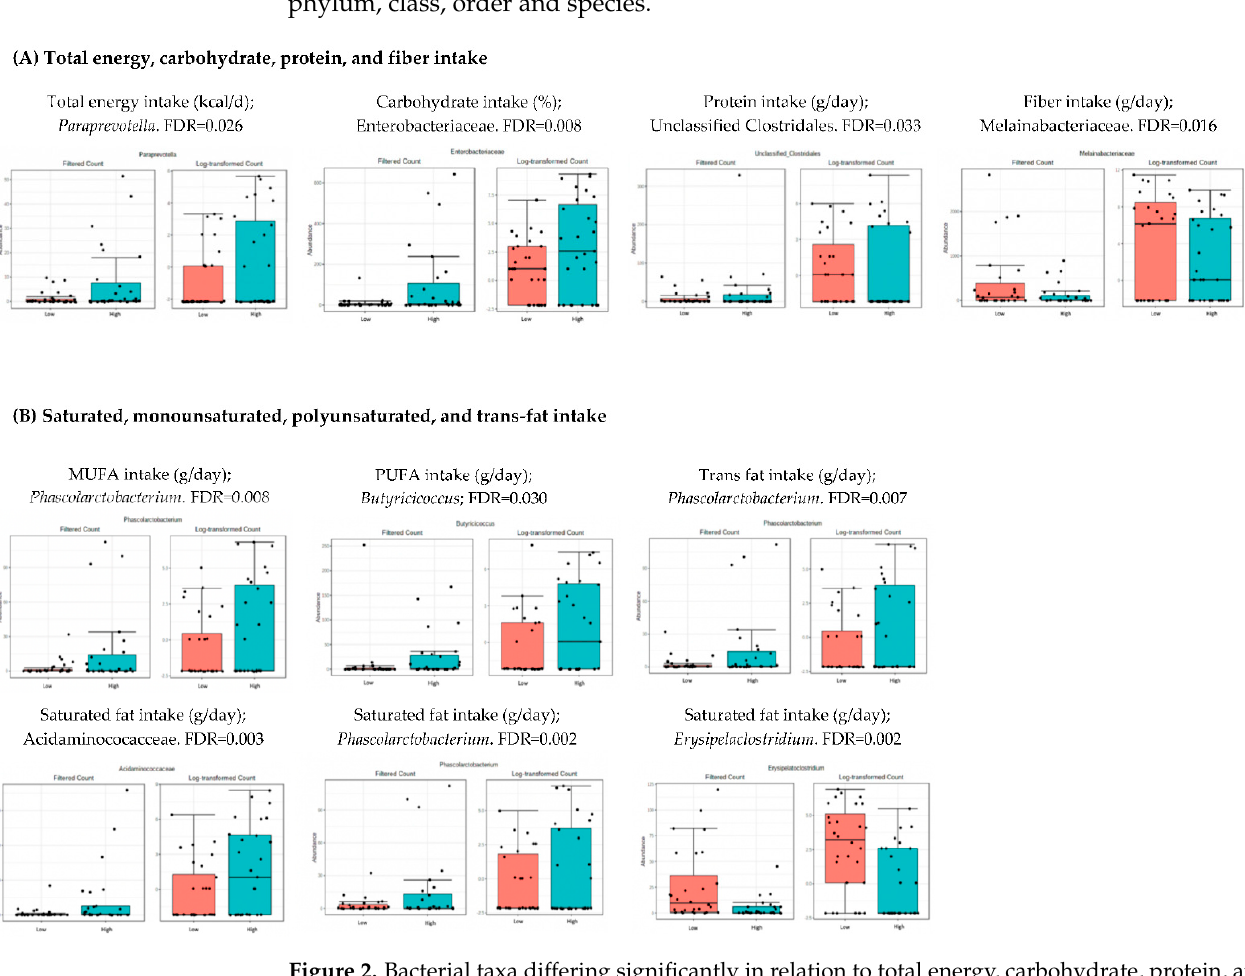
Figure 2. Bacterial taxa differing significantly in relation to total energy, carbohydrate, protein, and fiber intake ( A ), as well as different types of fat: monounsaturated, polyunsaturated, saturated, and trans ( B ) (FDR < 0.05). Red boxes represent participants with lower consumption, and blue boxes represent participants with higher consumption of the specified food group compared to the median.